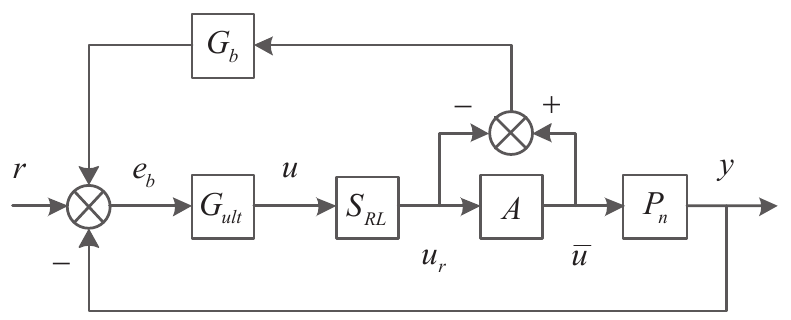
Figure 3. The reference controller with anti-windup module.